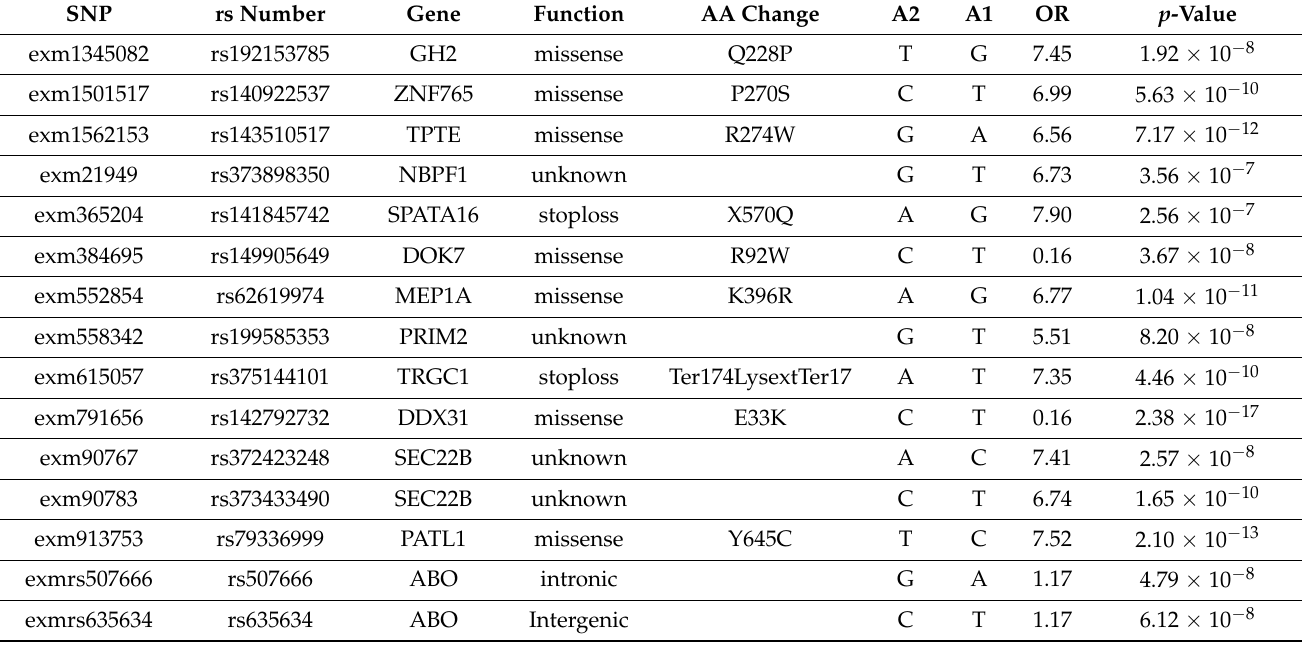
Table 3. Annotations of 15 SNPs associated with stroke on exome-wide